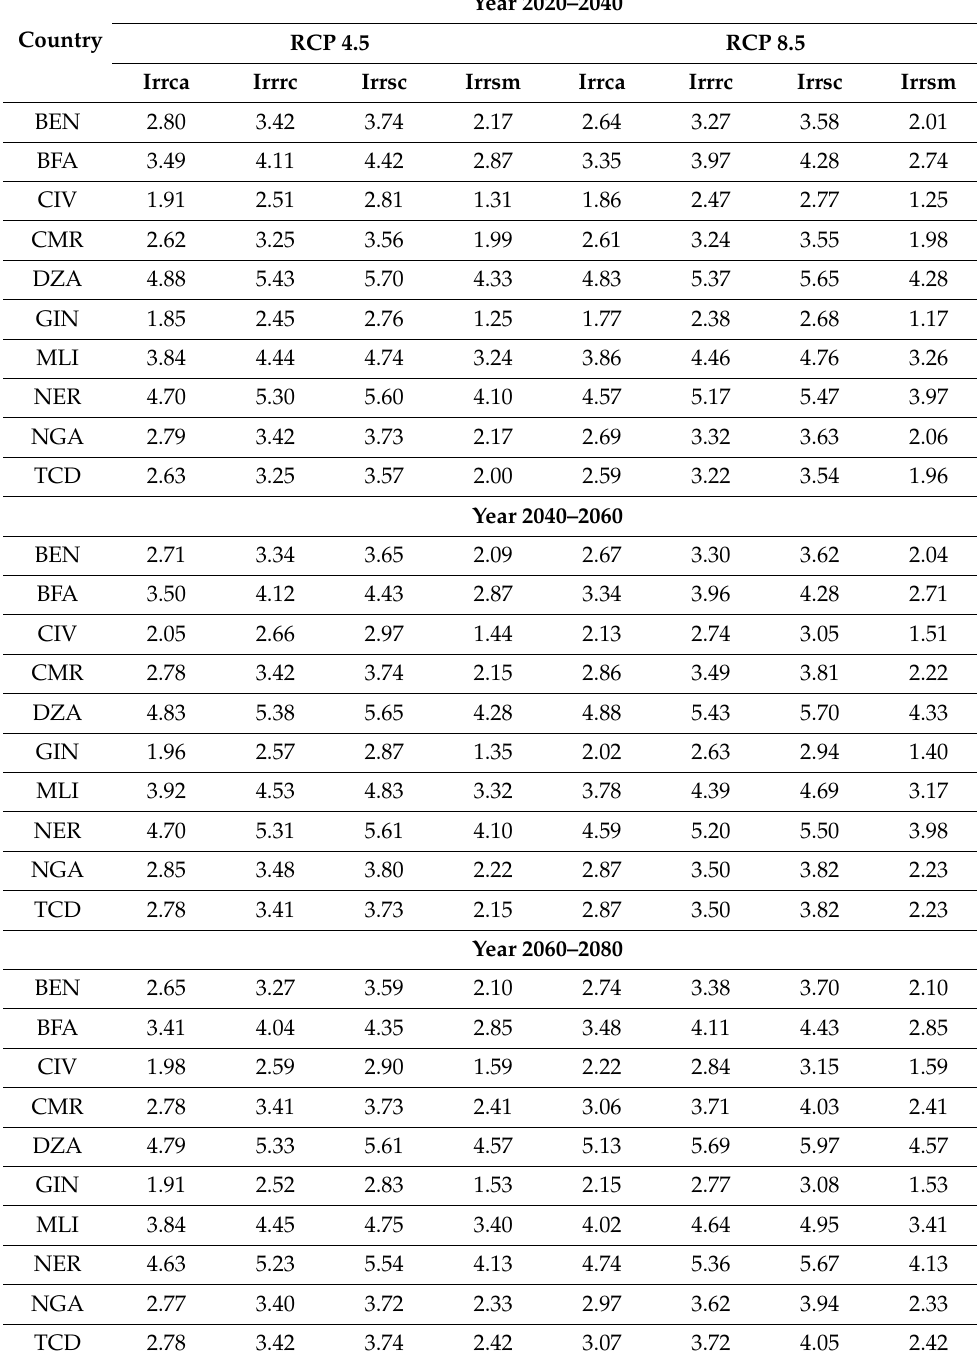
Table 2. Total irrigation water requirements (IRW) in mm/day under